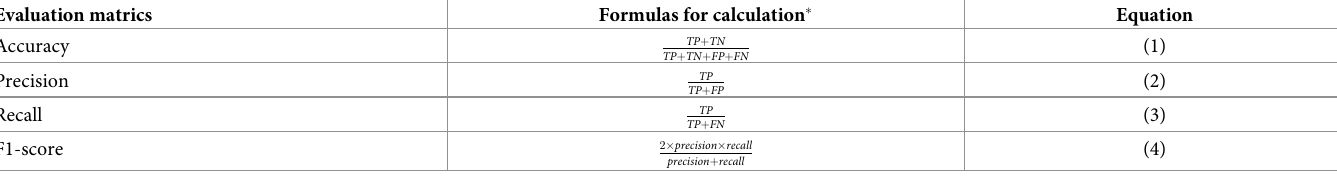
Table 1. Formulas for calculating the evaluation matrics from a confusion